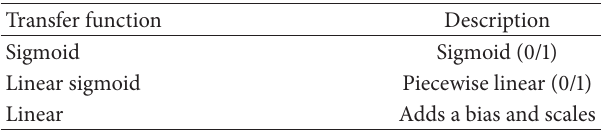
Table 1: Applied transfer functions.